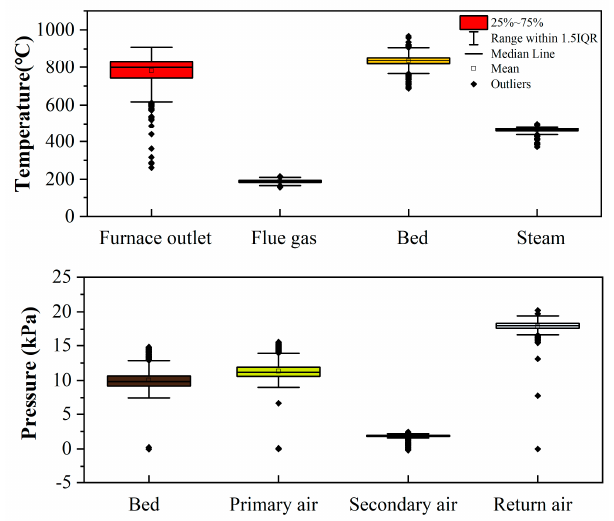
Figure 6. Comparison of the statistics for the temperature of furnace outlet, flue gas, bed, and steam, the pressure of bed, primary air, secondary air, and return air.